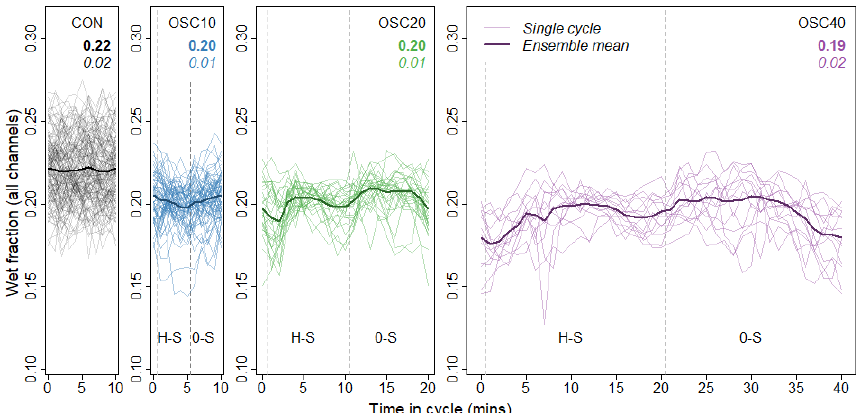
Figure 7. Wet fraction (across the whole fan, measured from all channels) versus time in the sediment supply oscillation cycle. The thin lines represent each individual supply oscillation cycle; the thick line is the ensemble mean. H-S denotes the high-supply period; 0-S denotes zero sediment supply. Coloured text indicates each experiment’s time-averaged mean (in bold) and standard deviation (in